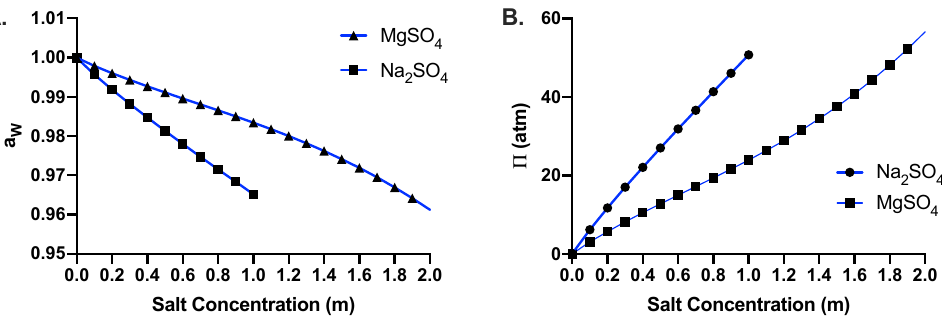
Figure 9. ( A ) Water activity, a W , and ( B ) osmotic pressure, Π , as a function of concentration of aqueous solutions of sodium and magnesium sulfate at T = 37 ◦ C, computed using the Pitzer